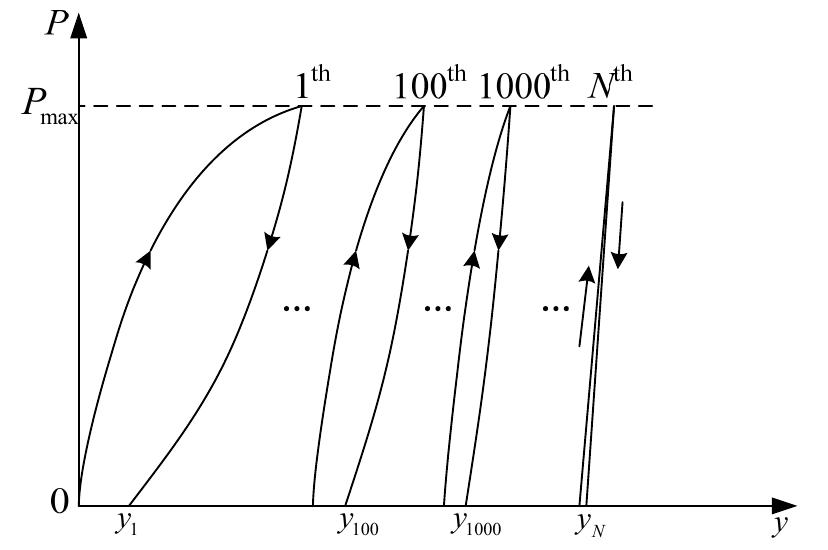
Figure 12. Definition of accumulated residual displacement.